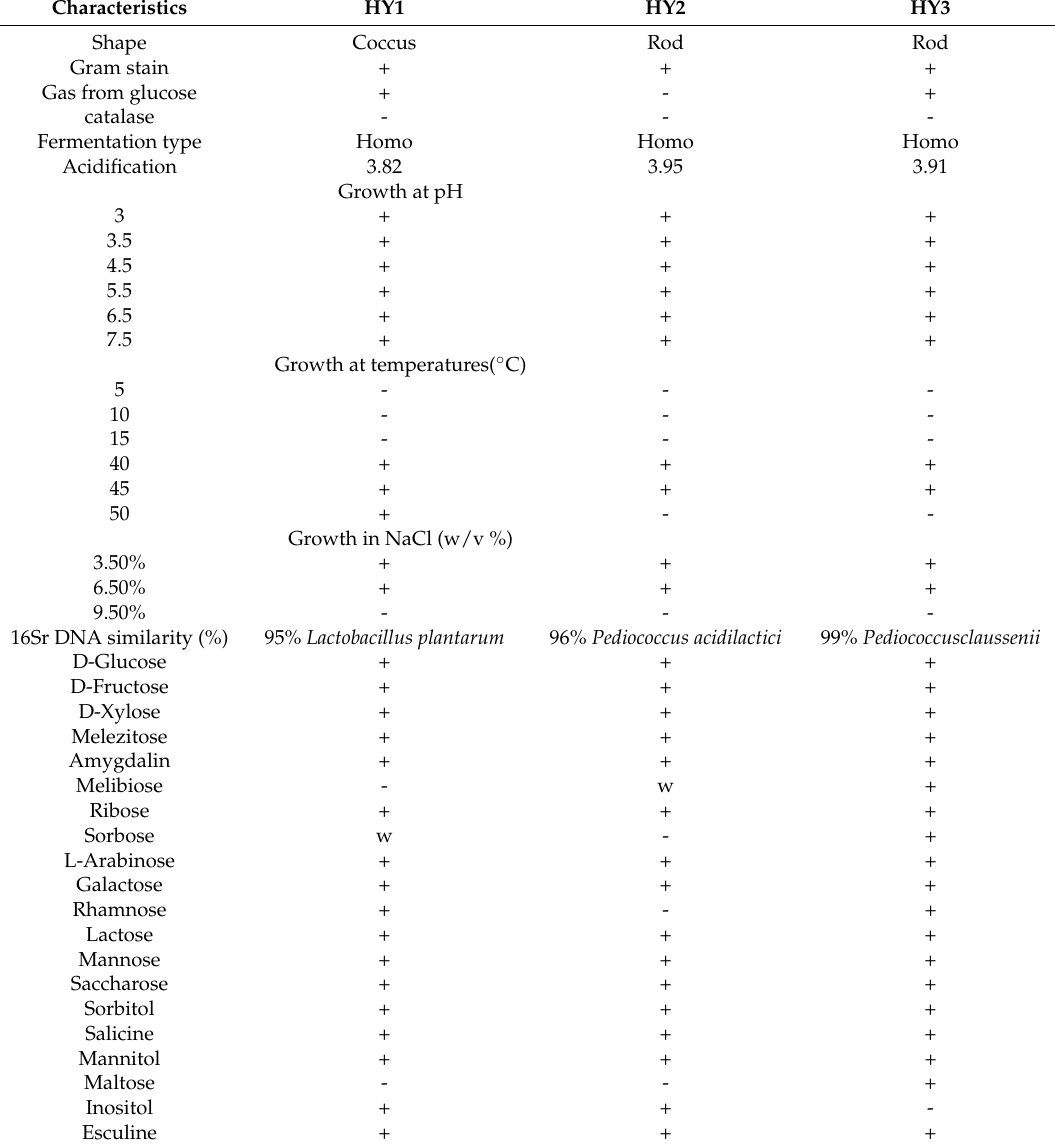
Table 2. Description and characteristic of LAB isolated from sweet